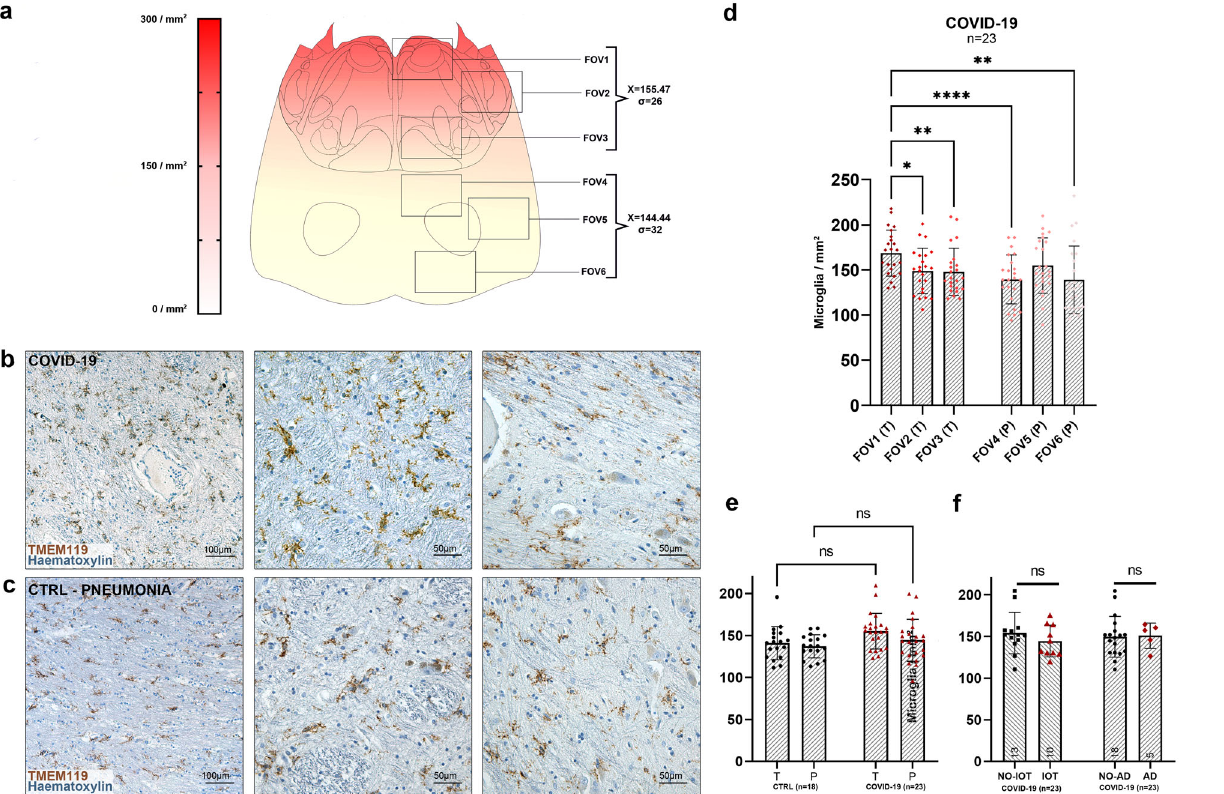
Fig. 9 No statistically-signi fi cant differences in microglial densities were found at the level of the pons. a Anatomical heatmap of activated microglia within the pons in COVID-19. b , c TMEM119 immunoperoxidase staining of comparable regions of the pons in COVID-19 subjects (above) and controls (below). d Welch one-way ANOVA of microglial densities per counting fi elds (FOV) reveals statistically signi fi cant differences between FOV1 (dorsal pons, including locus coeruleus) with other pontine counting fi elds. e Welch one-way ANOVA between anatomical compartments (T, tegmentum; P, pes) between COVID-19 subjects ( n = 23, red) and controls ( n = 18, black) reveals no statistically signi fi cant differences either at the level of the medullary tegmentum ( p = 0.55) and pes ( p = 0.98). f Welch corrected t -test plot of microglial densities (microglia/mm 2 ) in the pons of COVID-19 subjects with ( n = 5, red) and without ( n = 16, black) Alzheimer ’ s disease neuropathological changes ( p > 0.05), and of COVID-19 subjects treated ( n = 10, red) and not treated ( n = 13, black) with intensive oxygen therapy ( p > 0.05). Error bars indicate standard